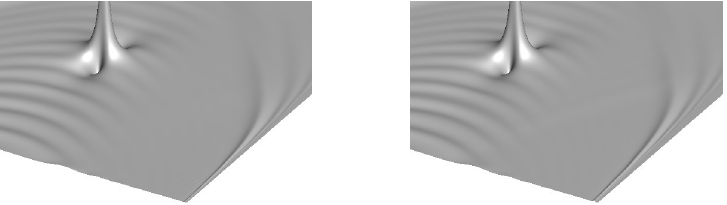
Figure 2. Comparing the smoothing e ff ect for functions h + ( y ) for upper band: the cubic polynomial (left) and the parabola (right).